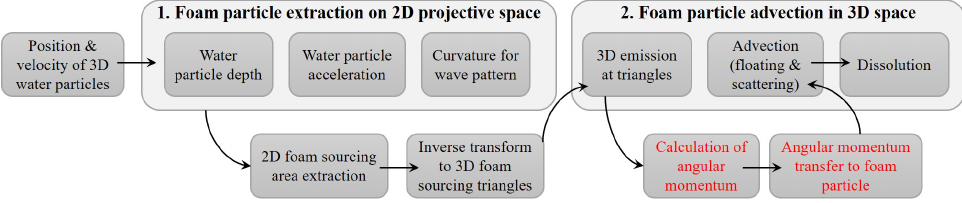
Figure 3. Algorithm